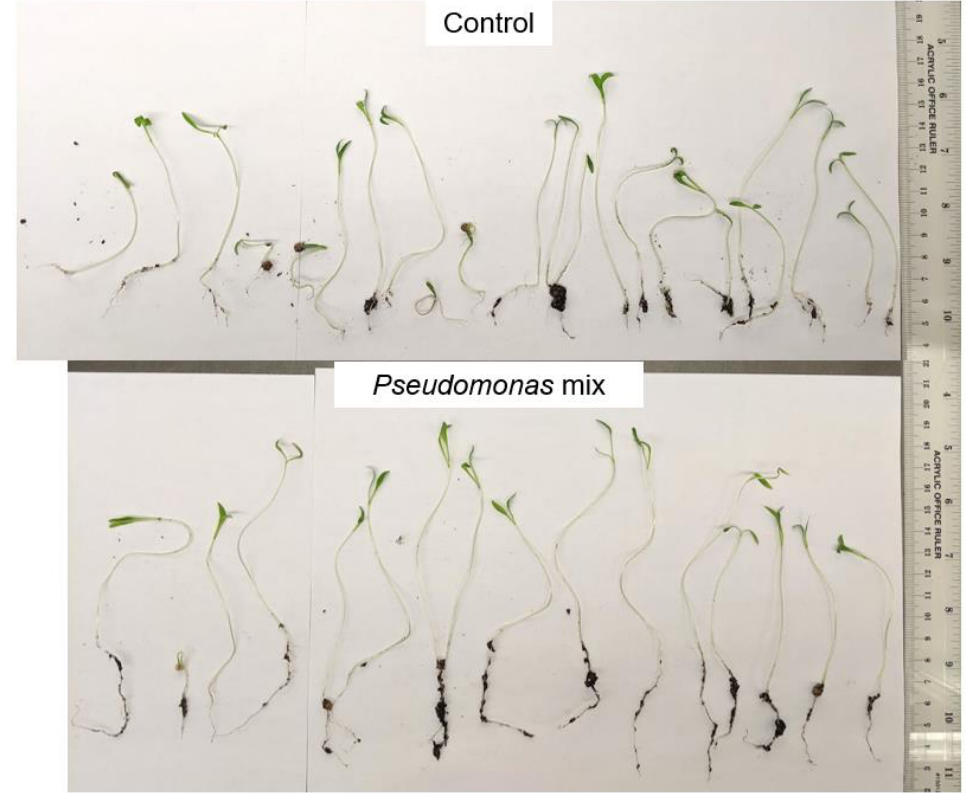
Figure 8. Visual comparison of coriander seedlings inoculated with a Pseudomonas sp. mix. Total number of seedlings germinated = 22, and 16, from top to bottom.